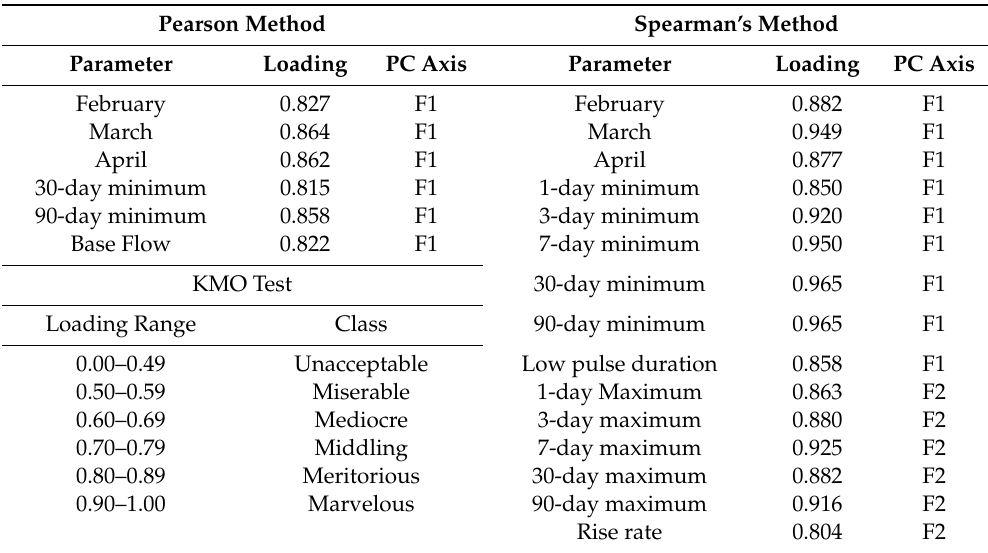
Table 5. IHA indices with meritorious class loadings for Pearson and Spearman’s method along with KMO test range